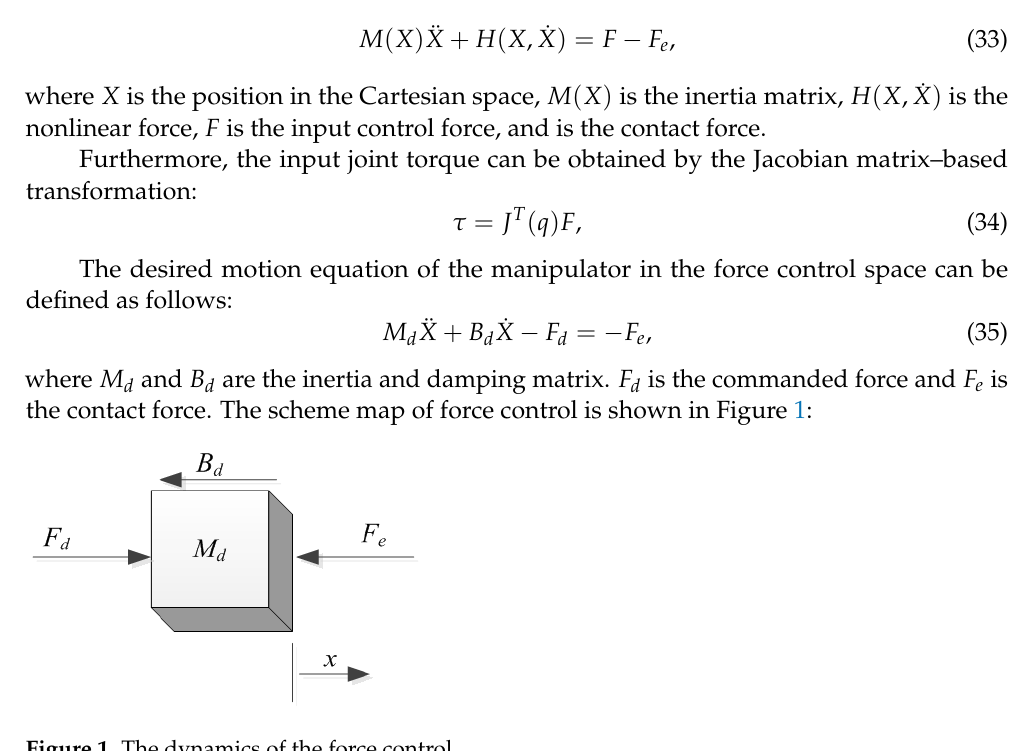
Figure 1. The dynamics of the force